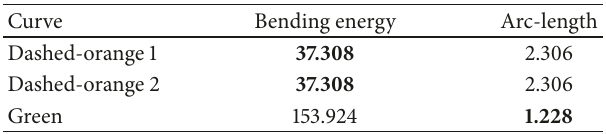
Table 1: Comparison of the bending energies and arc-length of the 3 important interpolants shown in Figure 5(a).